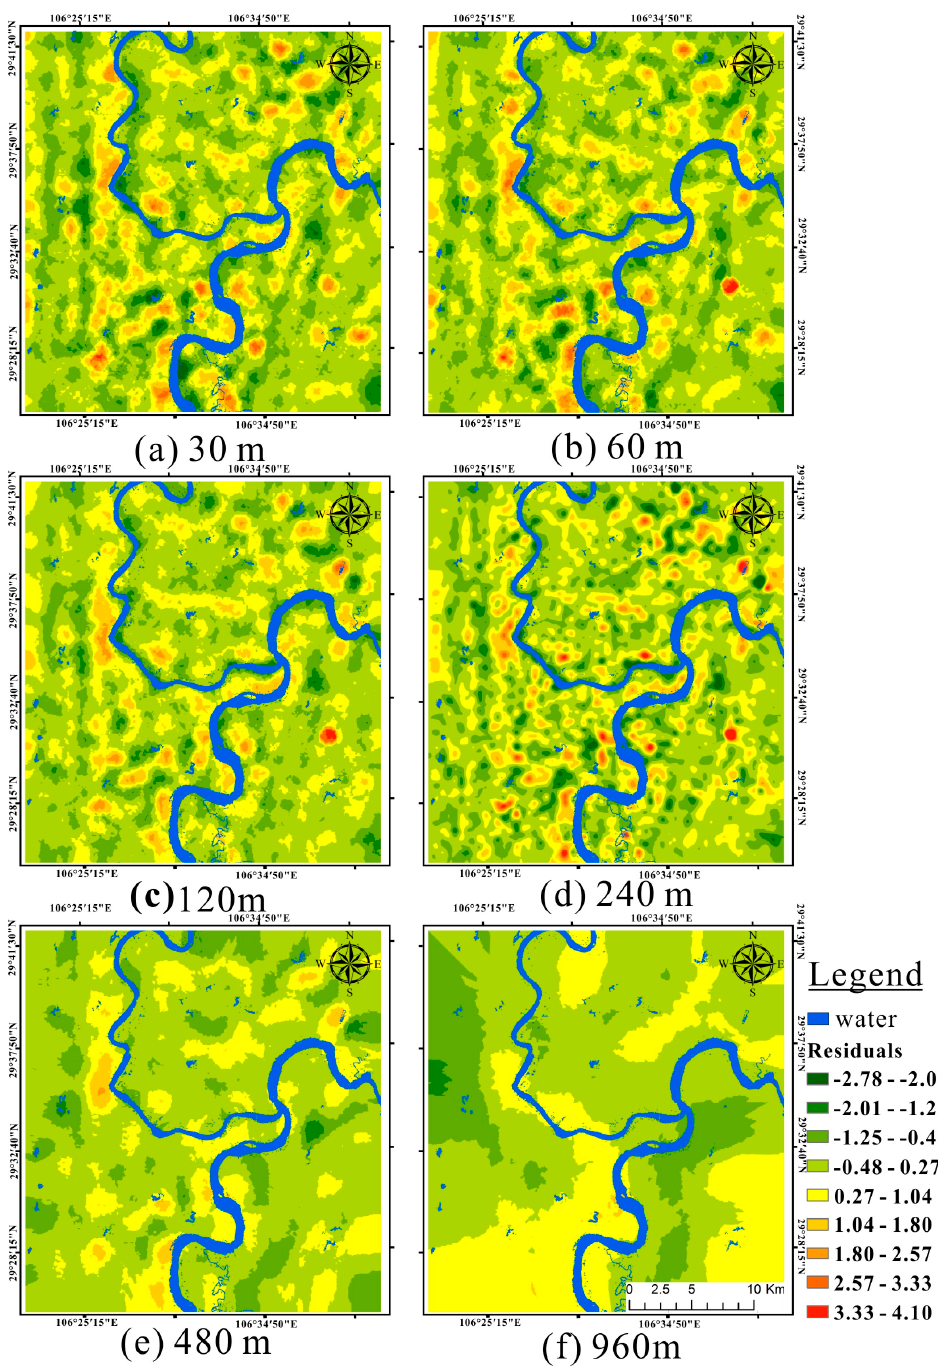
Figure 6. The spatial distribution of the local residuals in the multi-factor GWR models (using the SAVI, IBI, and NDSI as the explanatory variables simultaneously) at different spatial resolutions; ( a )–( f ) represent the spatial resolutions of 30 m, 60 m, 120 m, 240 m, 480 m, and 960 m, respectively. Moreover, the blue area represents water.